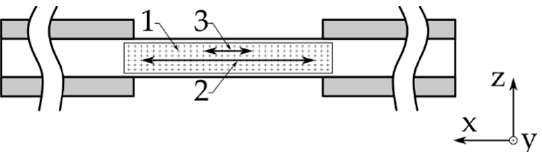
Figure 4. The investigated strain post-processing techniques applied to a compression specimen: 1 . strain field measurement, 2 . long extensometer, 3 . short extensometer.